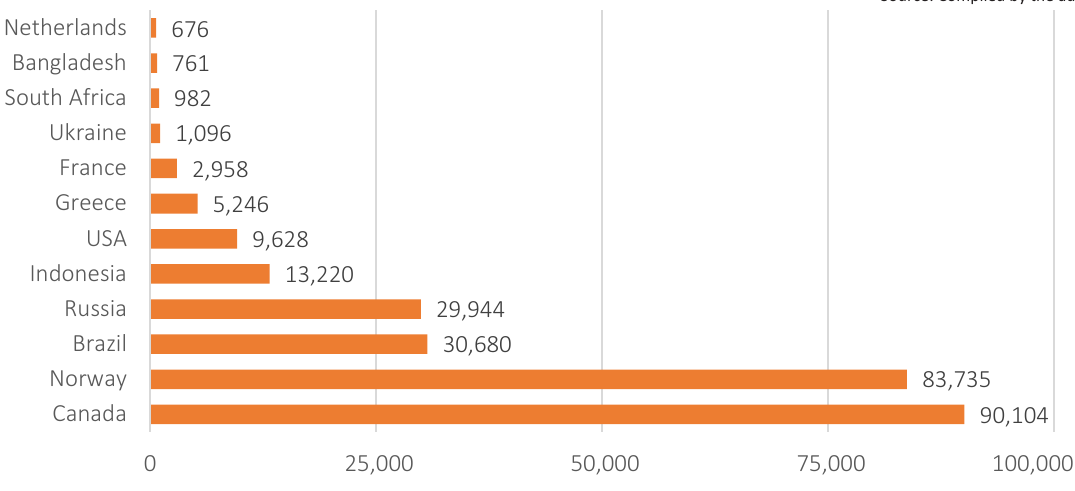
Figure 1. Resources of fresh water in different countries on average per person, м